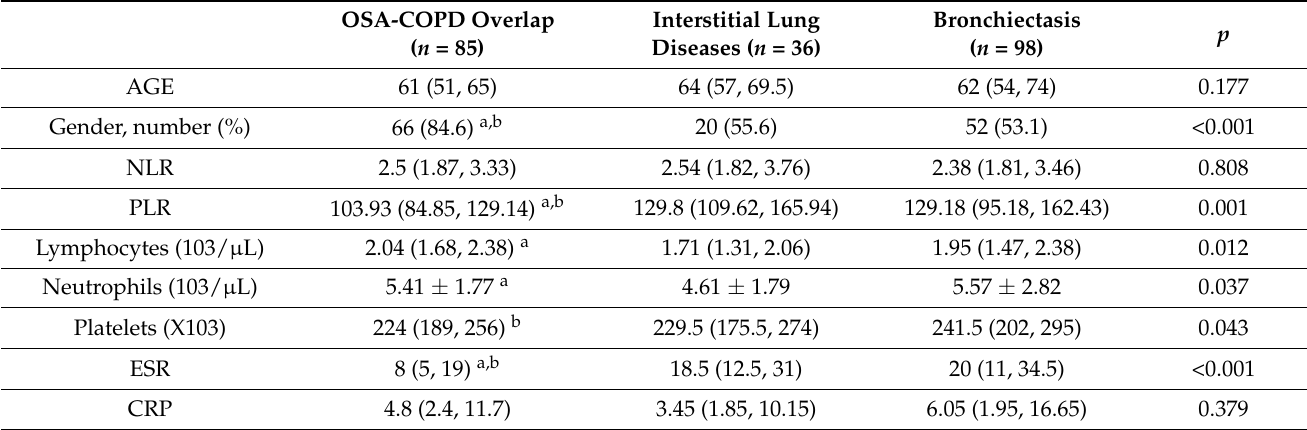
Table 3. The characteristics of the chronic disease groups.